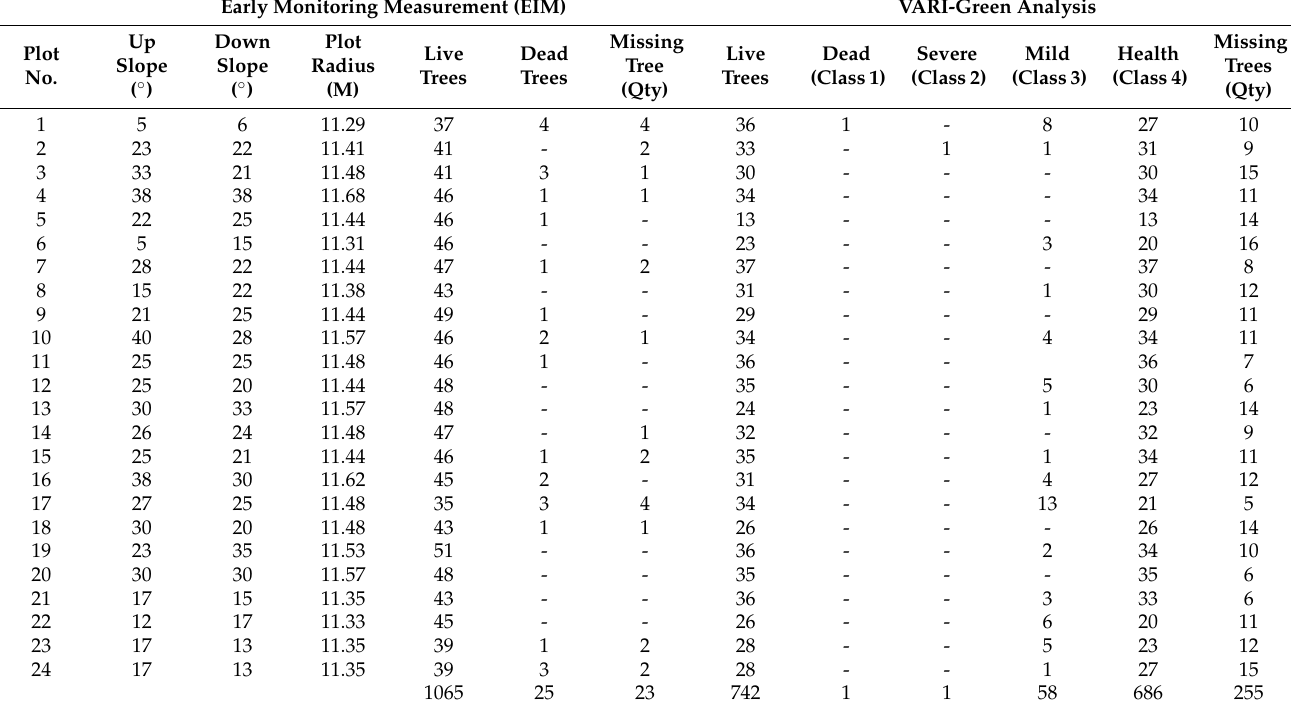
Table 6. Early monitoring measurement and results of VARI-green analysis.